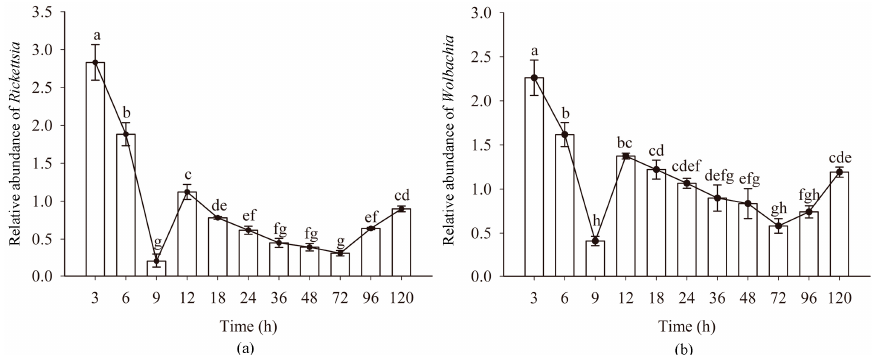
Figure 2. The relative abundance of Rickettsia and Wolbachia in B. tabaci eggs at different time intervals: ( a ) relative abundance of Rickettsia ; ( b ) relative abundance of Wolbachia . n = 3 biological replicates. Error bars represent the standard error of the mean; Means marked with different letters are significantly different from each other ( p ≤